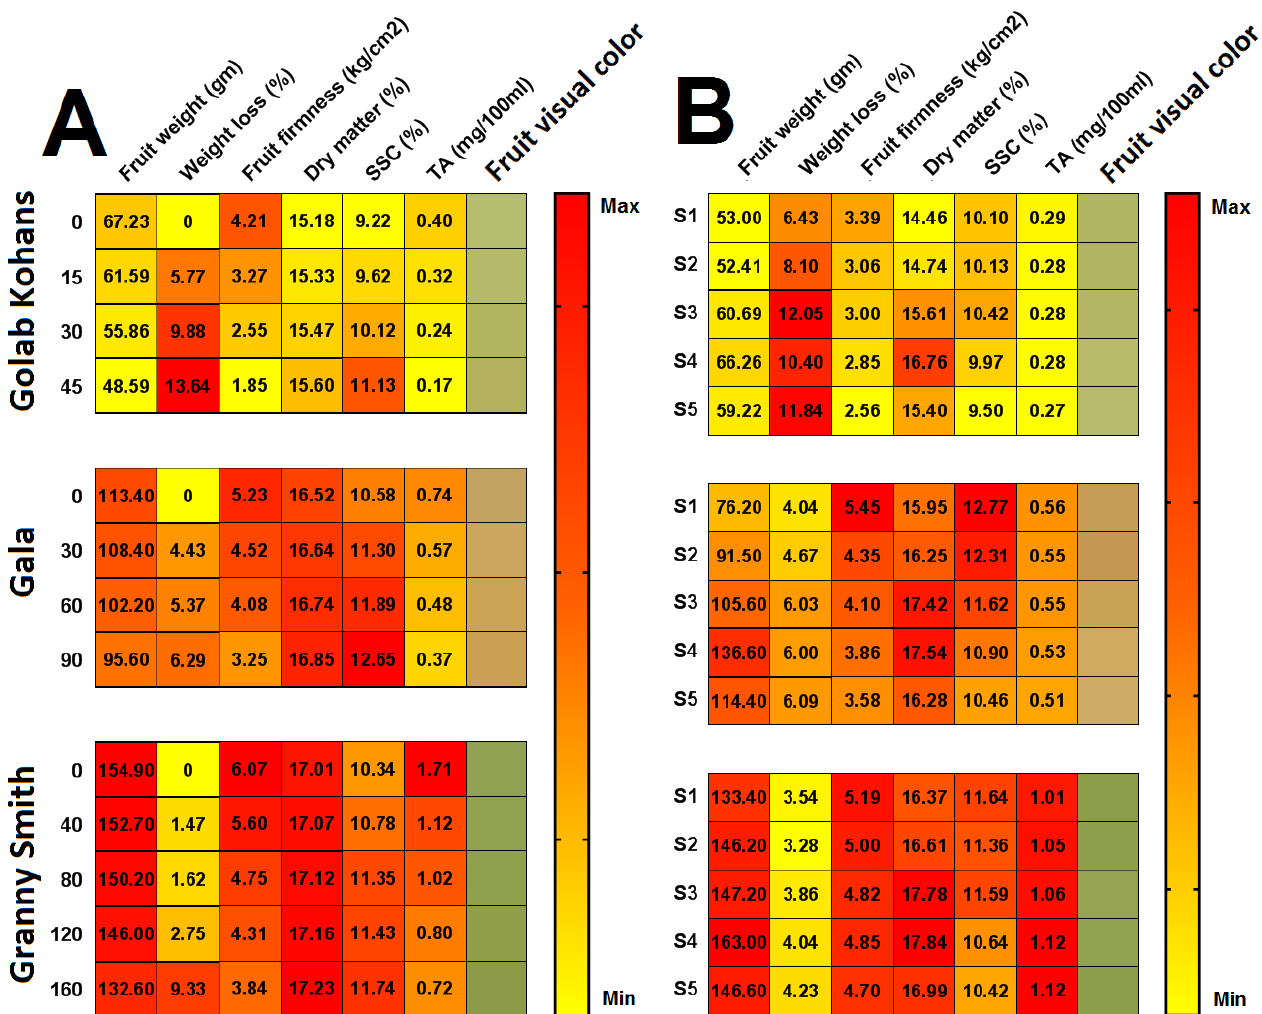
Figure 1. Mean values of the studied traits for the three cultivars of (Golab Kohans, Gala, and Granny Smith) against different storage evaluation stages (A) and the different used nutrition solutions (B). colors correlated with maximum and minimum values in each trait. Fruit visual color is a digital identification for colors obtained from Colorimetric device and has no relation to the scale. 4.